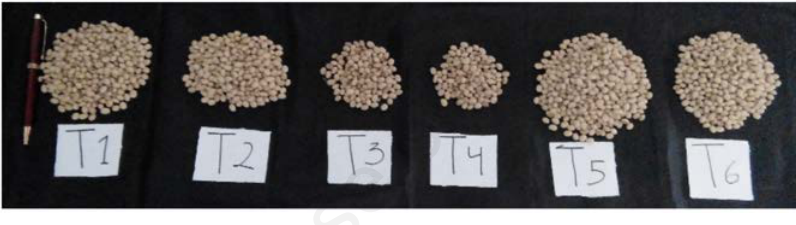
Figure 3. Soybean dried seed per plant Aged 14 WAP on different cropping pattern treat- ment: T1 row cropping, T2 strip cropping, T3 row relay (TK), T4 strip relay (TK), T5